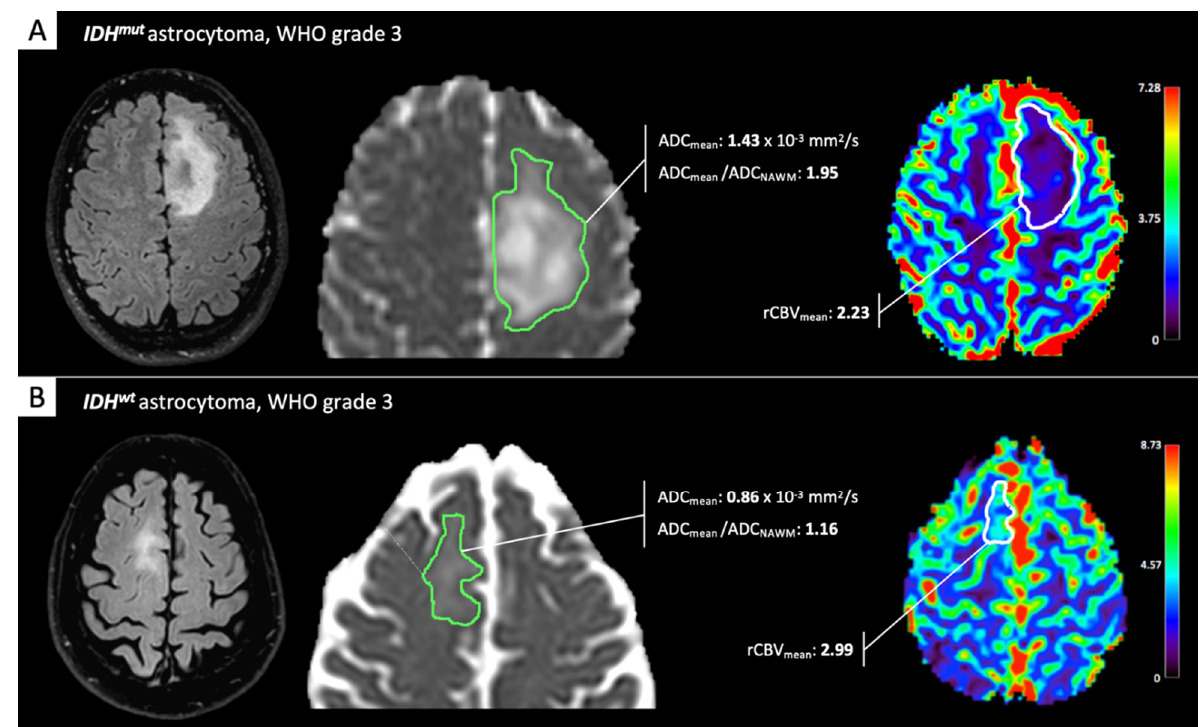
Figure 1. Perfusion and diffusion assessment of lower-grade glioma (LGG). MRI datasets were retrieved from the archive of our Institution. Diffusion MRI (dMRI) and perfusion-weighted imaging (PWI) features from one isocitrate dehydrogenase mutant (IDH mut )-LGG ( A ) and one IDH wild type (IDH wt )-LGG ( B ) were evaluated through a clinically feasible single-slice region of interest (ROI) approach. IDH wt -LGG exhibits more “aggressive” aMRI features, in particular a mean apparent diffusion coefficient (ADC mean )/normal-appearing white matter (ADC NAWM ) ratio lower than 1.8, the proposed cutoff for IDH wt status prediction by Maynard et al. [27] and Thust et al. [28].